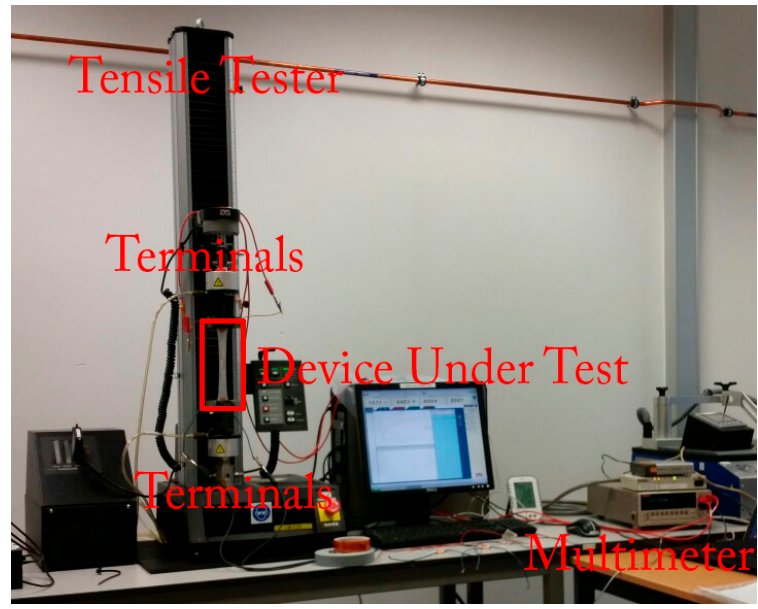
Figure 6. Tensile tester (Instron 5543) with the benchtop multimeter (Keithley 2001) performing the electrical measurements at the right-hand side. The multimeter was triggered over a network connection, and data were recorded using a secondary computer.